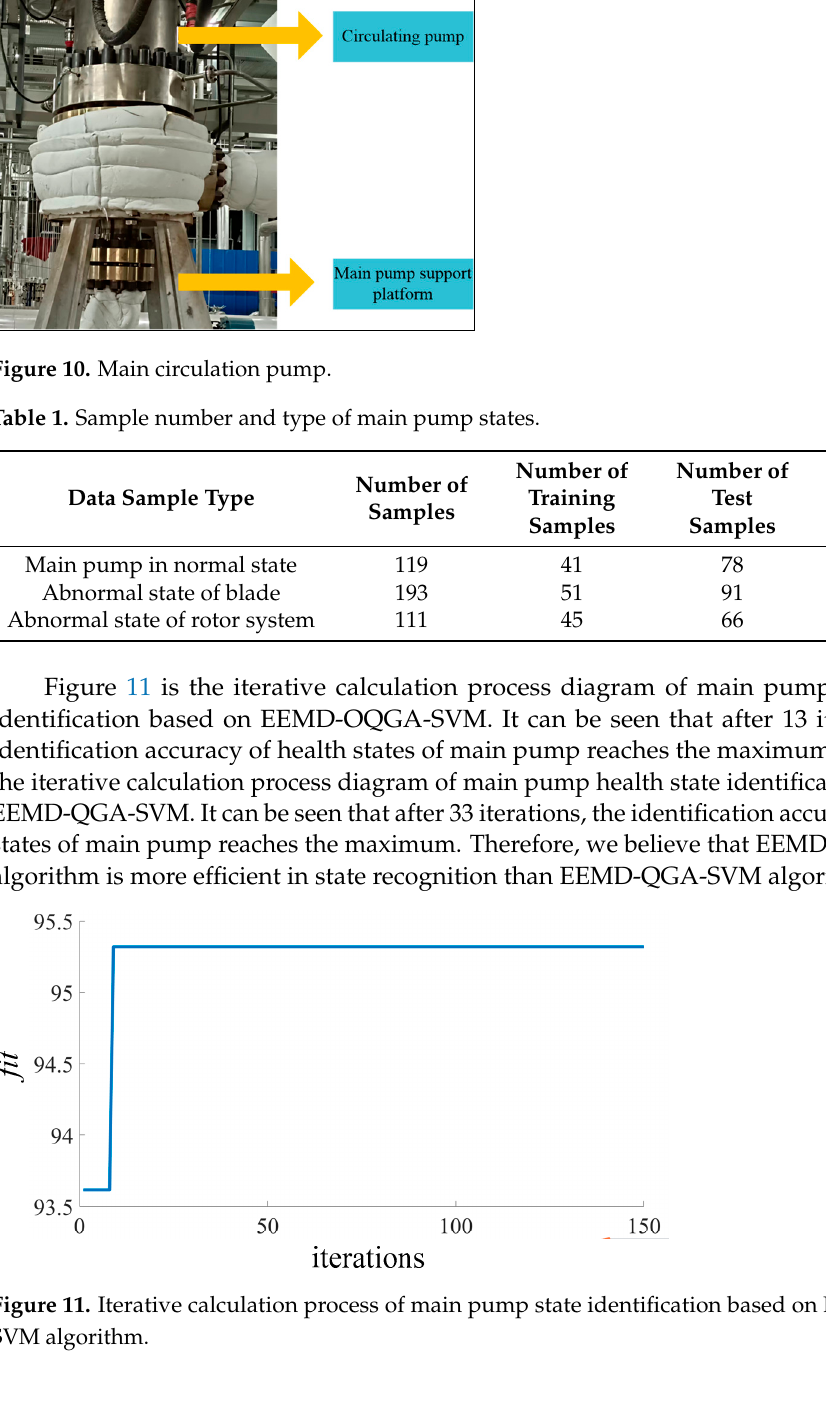
Figure 12. Iterative calculation process of main pump state identification based on EEMD-QGA- SVM algorithm. Figure 13 is the result diagram of main pump health state identification based on EEMD-OQGA-SVM. The diagram shows the state recognition results of 235 state samples of main circulation pump by the EEMD-OQGA-SVM algorithm. Figure 14 is the result diagram of main pump health state identification based on EEMD-QGA-SVM. The dia- gram shows the state recognition results of 235 state samples of main circulation pump by the EEMD-QGA-SVM algorithm. Figure 15 is the result diagram of main pump health state identification based on EEMD-SVM. The diagram shows the state recognition results